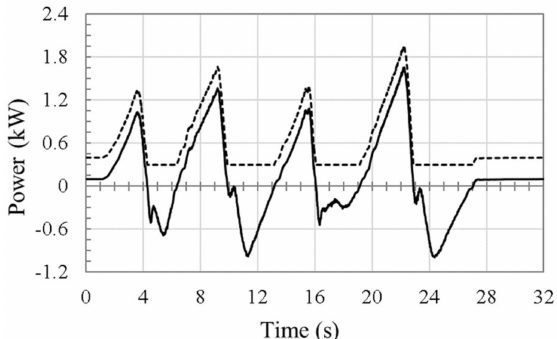
Figure 21. Hydraulic power delivered/received by pumps in proposed circuit (solid line) and power consumed by pump in a load-sensing circuit (dashed